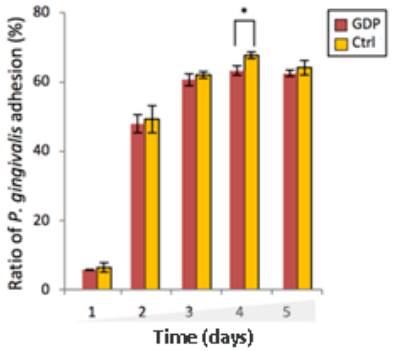
Figure 6. After-treatment adhesion of P. gingivalis onto Zr discs. At day 1 post-infection (dpi), the GDP-treated substrate discs demonstrated a lower density of bacterial adhesion. At other time points, the Ctrl-Zr discs exhibited higher bacterial adhesion than the GDP-treated discs. * p < 0.05. adherent bacteria was similar in the control and GDP groups, only di ff ering by the number of adherent bacteria. The GDP-treated Zr disks demonstrated less bacterial colony formation than the control discs. From 3 dpi onward, the quantified data indicated an increase of P. gingivalis accumulation (Figure 7B), implying that the initial bacterial adhesion and growth were related to attachment. Altogether, these findings imply that surface roughness can help the bacterial infection development by benefiting the P. gingivalis initial adhesion.